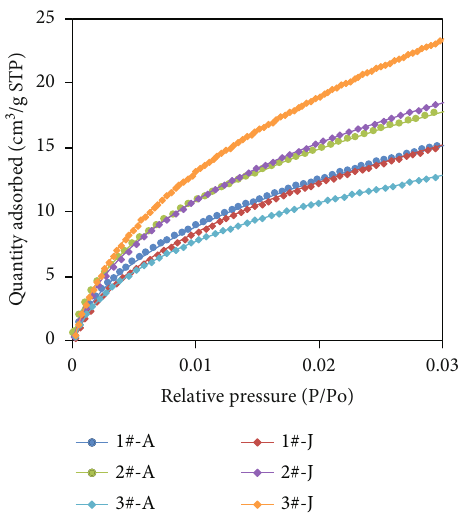
Figure 6: The CO adsorption isotherm of vitrain and 2